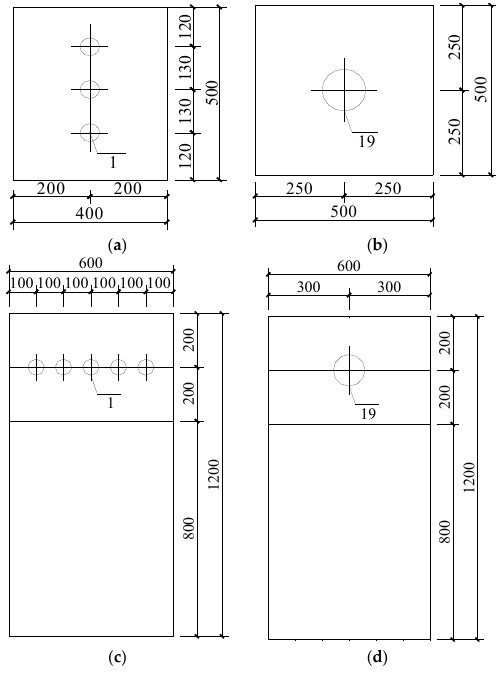
Figure 4. General view of the specimens: ( a ) straight tendons with 1, 3, 12, 19 and 22 wires; ( b ) curve tendons with 1 and 3 wires; and ( c ) curve tendons with 12, 19 and 22 wires.